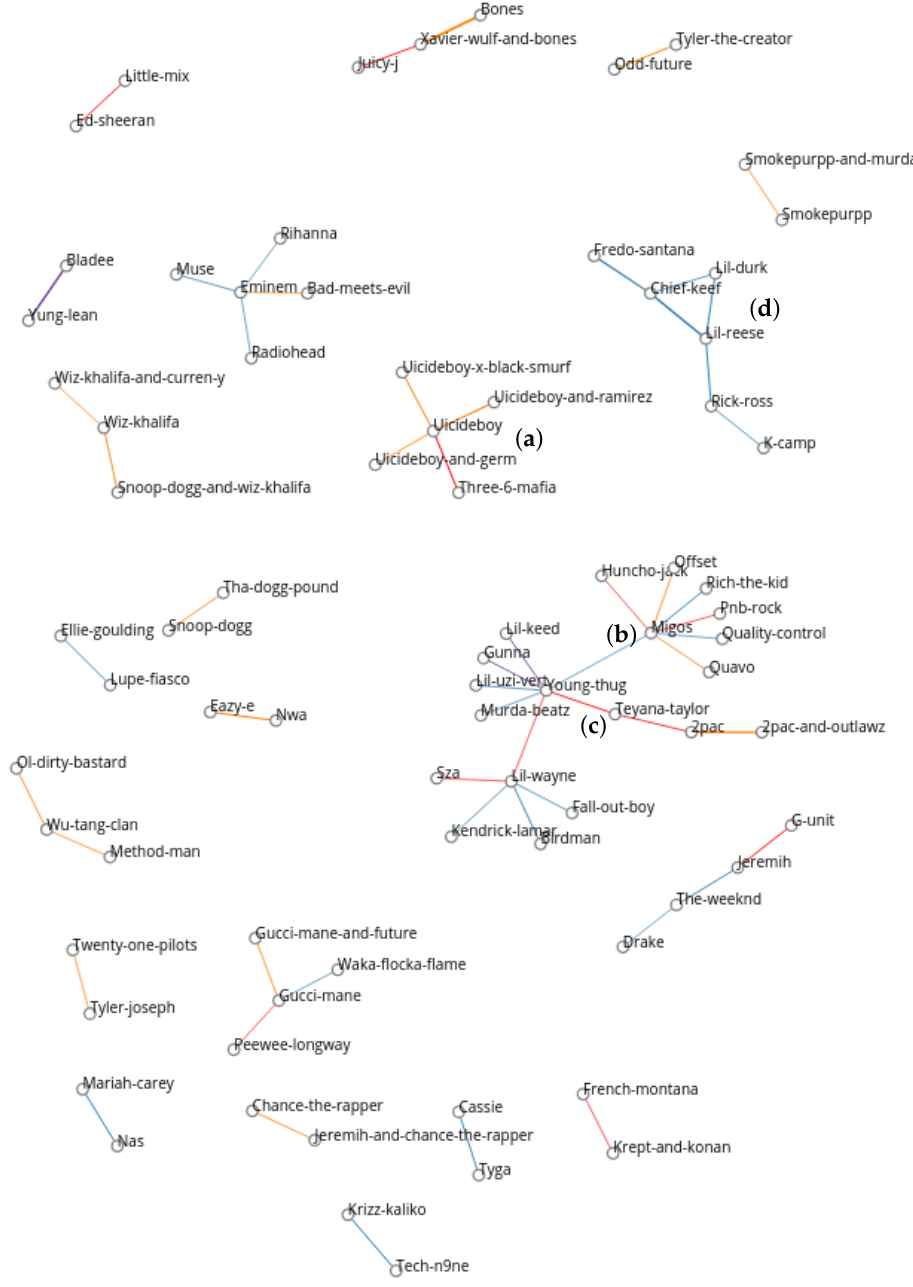
Figure 3. An excerpt of the similarity network of English rap artists based on the most similar lines in their lyrics. Collaboration partners tend to be connected. ( a ) $uicidebo$ and Three 6 Mafia, ( b ) Migos and two of their members with feature partners, ( c ) artists that collaborated with Young Thug or were signed by his label, and ( d ) multiple artists from Chicago and associated with the genre